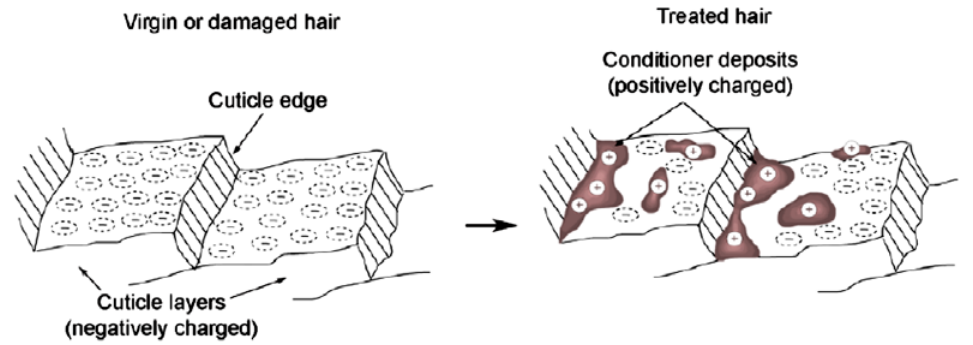
Figure 3. Scheme representing a damaged hair surface and the same surface upon the deposition of the conditioner layer. Reprinted from [24], Copyright (2008), with permission from Elsevier.